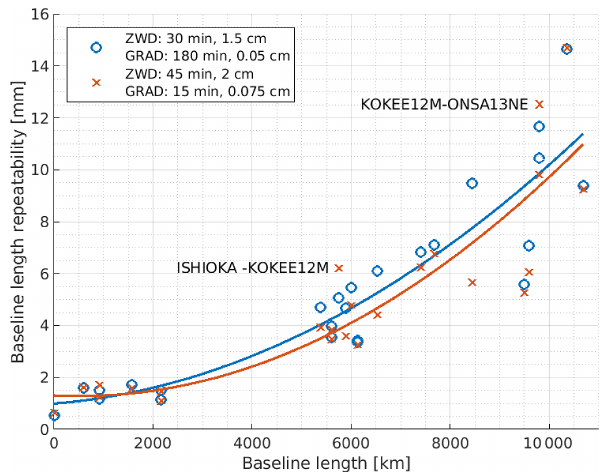
Figure 5. Baseline length repeatability of the reference parametriza- tion (blue) and the best parametrization (red) with a fitted second degree polynomial approximation.